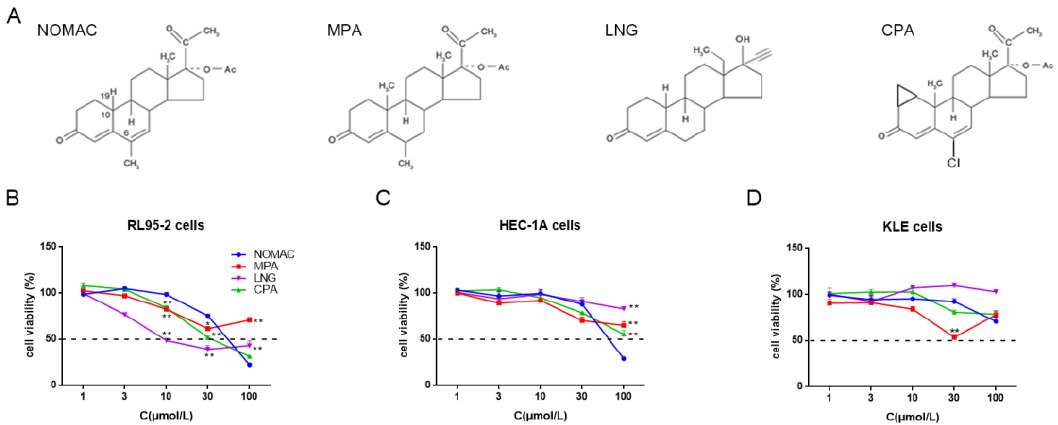
Figure 2. Nomegestrol acetate (NOMAC) simultaneously inhibited the growth of both RL95-2 and HEC-1A cells. ( A ) The structures of nomegestrol acetate (NOMAC), medroxyprogesterone acetate (MPA), levonorgestrel (LNG), or cyproterone acetate (CPA). ( B , C and D ) Inhibitory effect of four progestins on the viability of RL95-2, HEC-1A, and KLE cells. Cells were treated with NOMAC, MPA, LNG, or CPA at the concentration of 1, 3, 10, 30, and 100 µ M for 48 h, respectively. Experiments were performed in triplicate each time and independently repeated three times with different passages of cells. The data were expressed as mean ± SEM. * p < 0.05, ** p < 0.01 vs. NOMAC treated cells. Table 1. Antiproliferative activity of various progestins on three types of human endometrial cell lines after treatment for 48 h, as presented as IC 50 (95% confidence interval) values (μM).